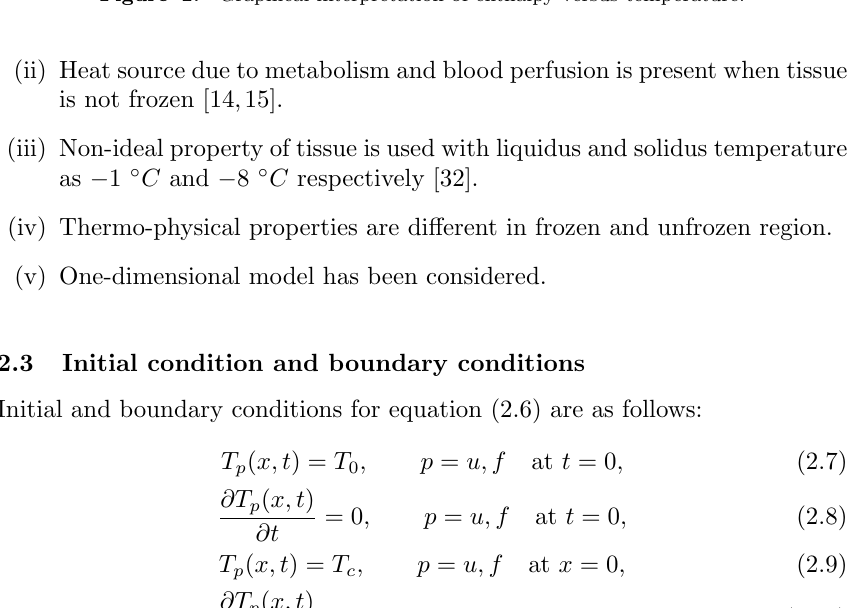
Figure 1. Graphical interpretation of enthalpy versus